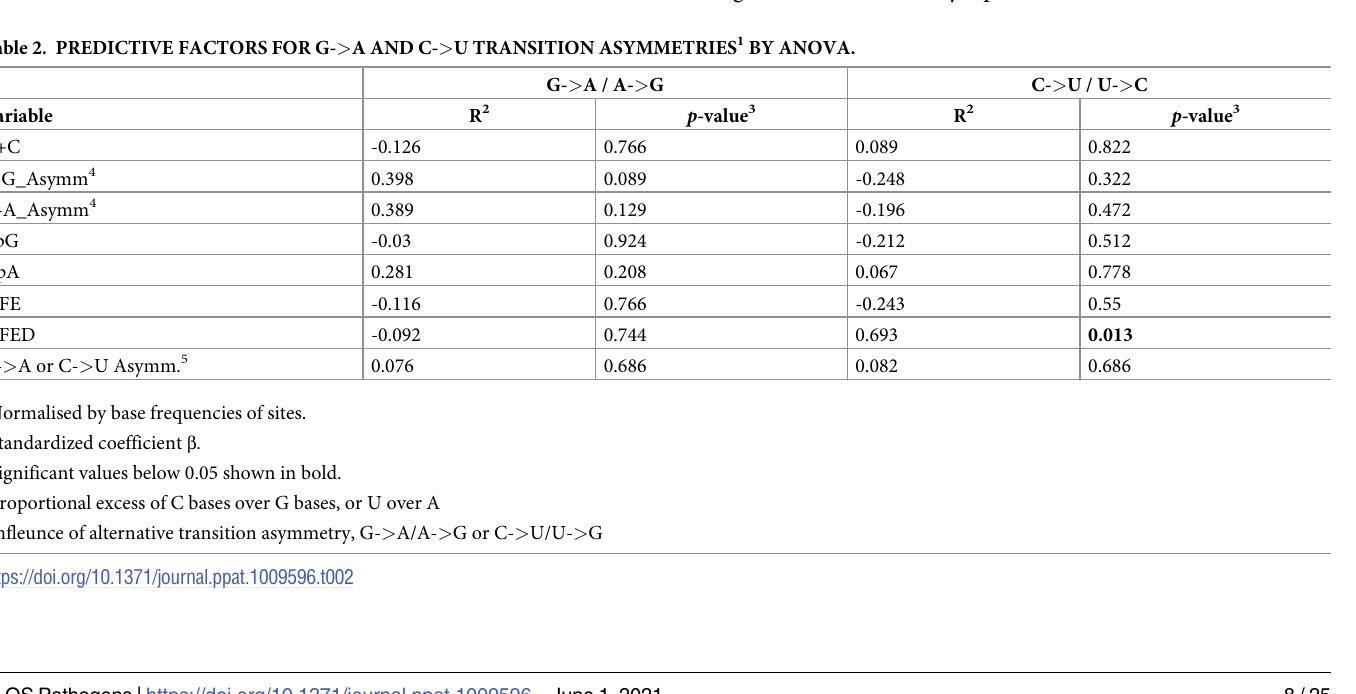
Table 2. PREDICTIVE FACTORS FOR G- > A AND C- > U TRANSITION ASYMMETRIES 1 BY ANOVA. G- > A / A- > G C- > U / U- > C R 2